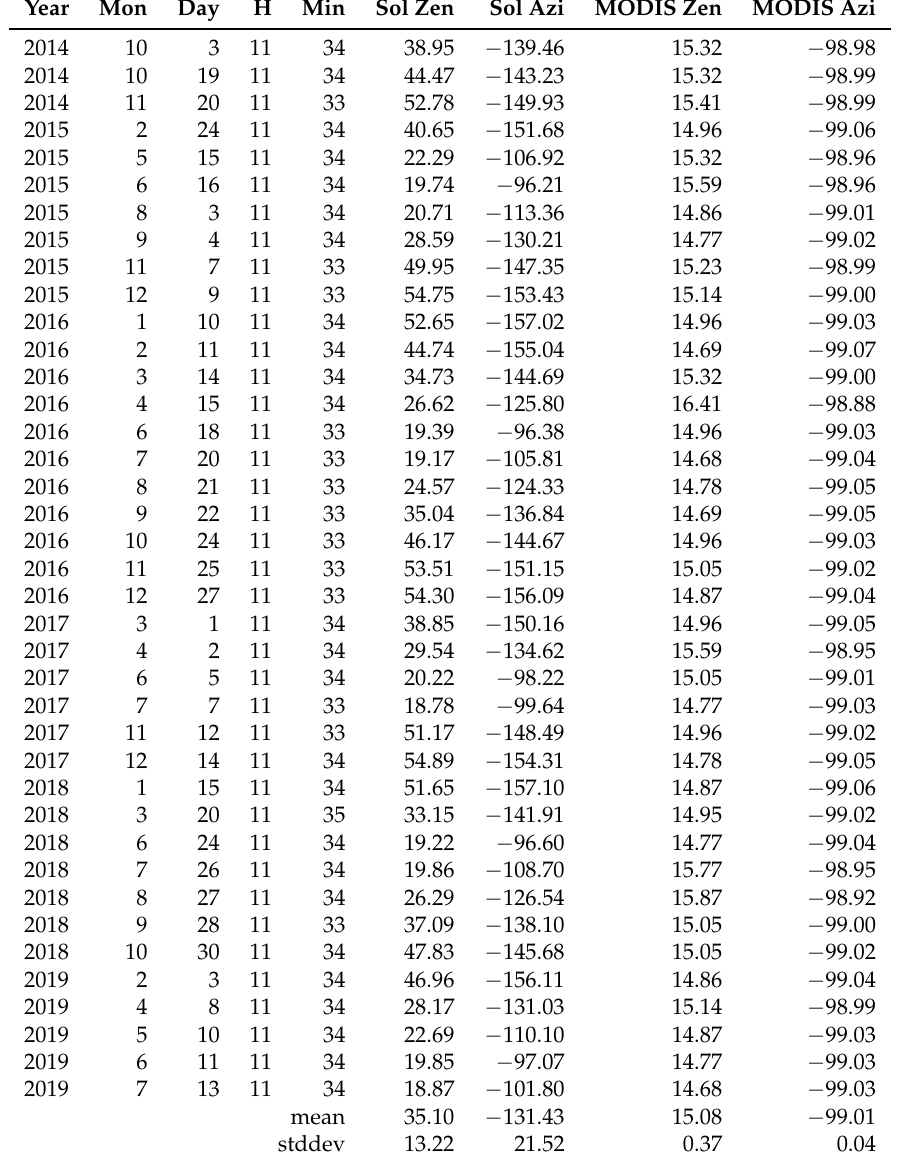
Table 4. Median UTC times of OCO-2 clear-sky nadir passes over Egypt1 during the first five years of mission, together with the corresponding solar and MODIS zenith and azimuth